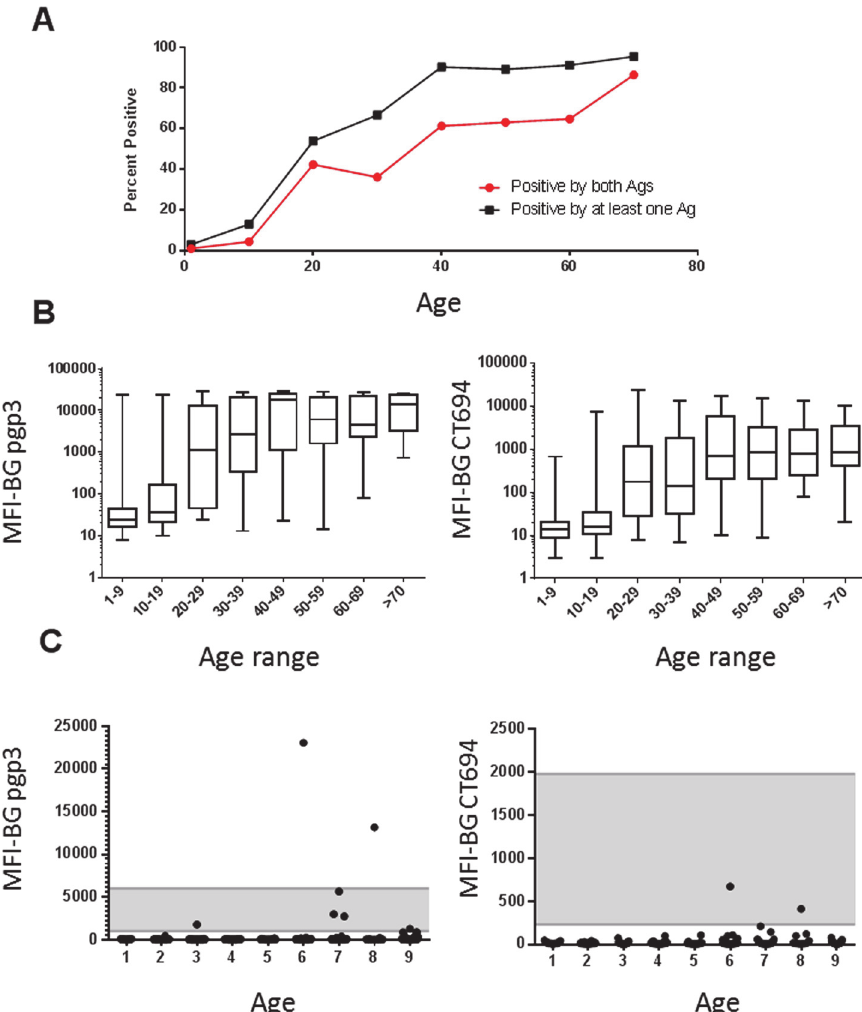
Fig 1. Antibody responses to Ct antigens 10 years after MDA cessation. A. Age-prevalence curves for antibody responses grouped by decade. Black squares represent individuals with any antibody-positive test (to pgp3 alone, CT694 alone, or both antigens), and red squares represent responses positive to both pgp3 and CT694. B. Plots show box-and-whiskers graph (min-max) of MFI-BG against age ranges grouped by decade for antibodies against pgp3 (left) and CT694 (right). C. Plots show age against MFI-BG for children aged 1 – 9. Each dot represents a single individual. Note the differences in the y-axis scales for pgp3 (left) and CT694 (right). Indeterminate range is shaded. Horizontal lines indicate cutoffs for antibody positivity. Ag = antigen.